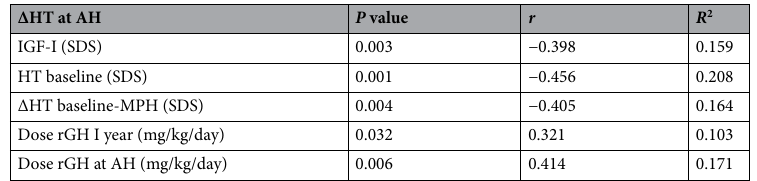
Table 3. Regression analysis data on correlations between height gain at adult height and other variables. HT height, AH adult height, IGF-I insulin-like growth factor-I, MPH mid-parental height, rGH recombinant growth